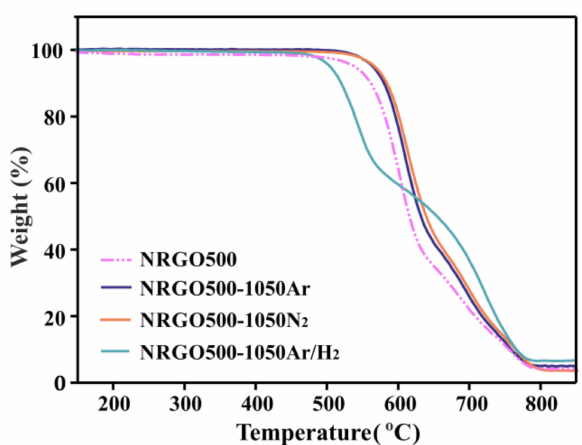
Figure 2. TGA of NRGO500 samples before (pink dashed line) and after (continuous lines) thermal annealing under N 2 , Ar, and Ar / H 2 at 1050 ◦ C. TGA were performed under flowing air at a heating rate of 10 ◦ C · min –1